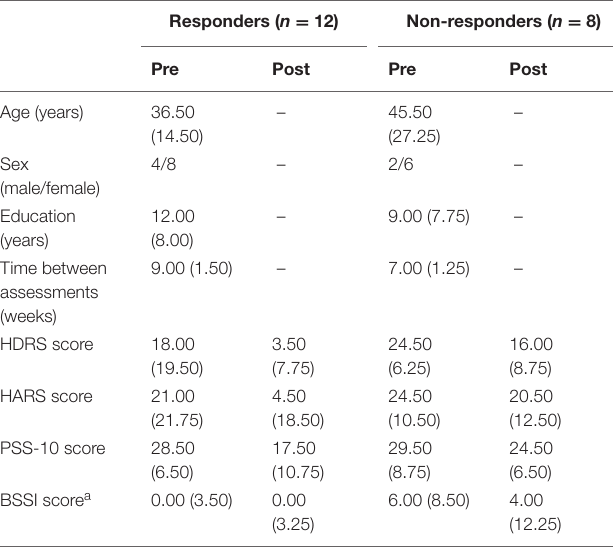
TABLE 2 | Description of the demographic and clinical data from responders ( n = 12) and non-responders ( n = 8) before and after 6–12 weeks of